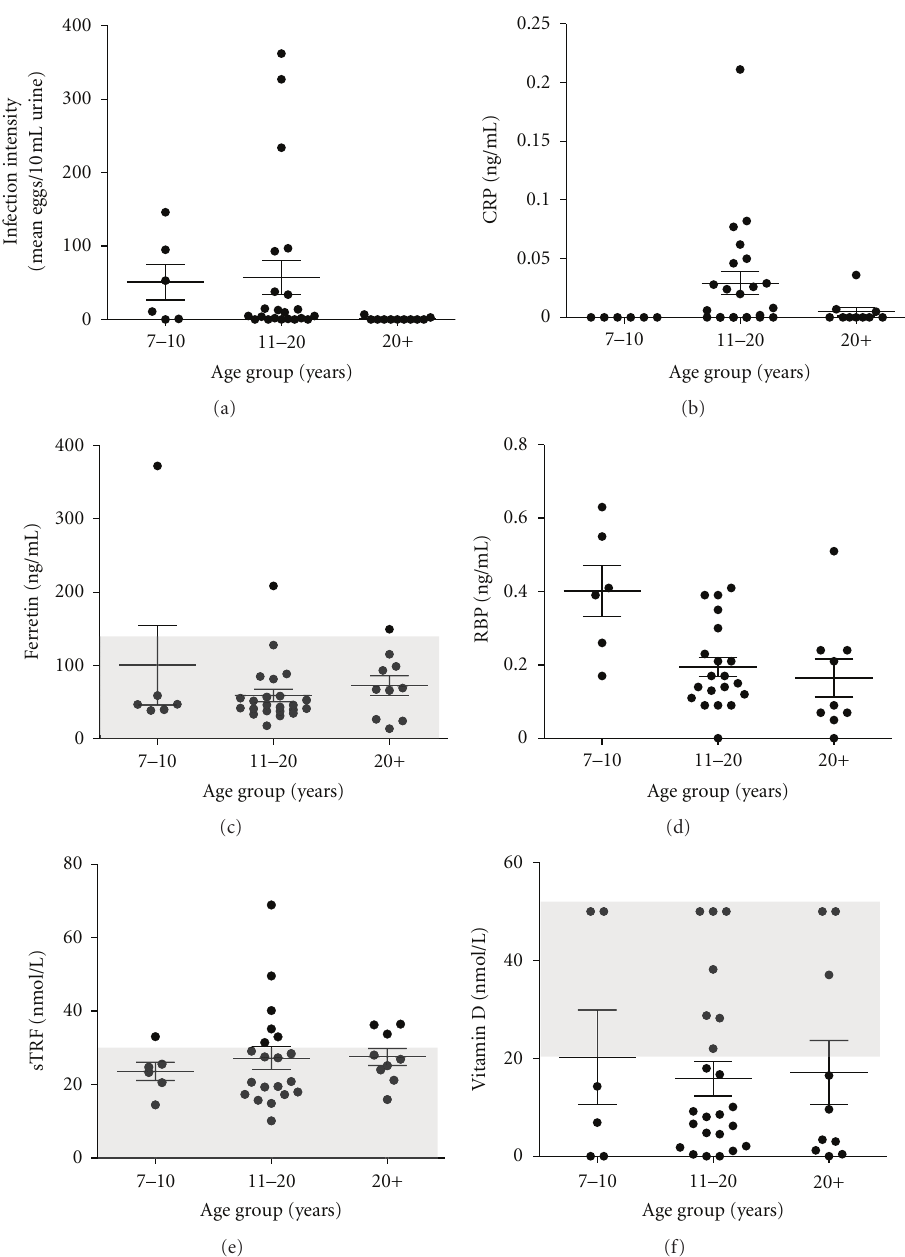
Figure 1: Age profiles of the host population infection and micronutrient levels. Samples for each age group are n = 6 for ≤ 10 years, n = 23 for 11–20 years, and n = 11 for 21+ years. Bars represent means and standard error of the mean. Shaded regions represent normal ranges of micronutrients. (a) Infection intensity, (b) C-reactive protein (CRP) levels, (c) ferritin levels (measure of stored iron levels), (d) retinol binding protein (RBP) levels (a measure of vitamin A levels), (e) soluble transferrin receptor (sTfR) levels (measure of functional iron levels), and (f) vitamin D